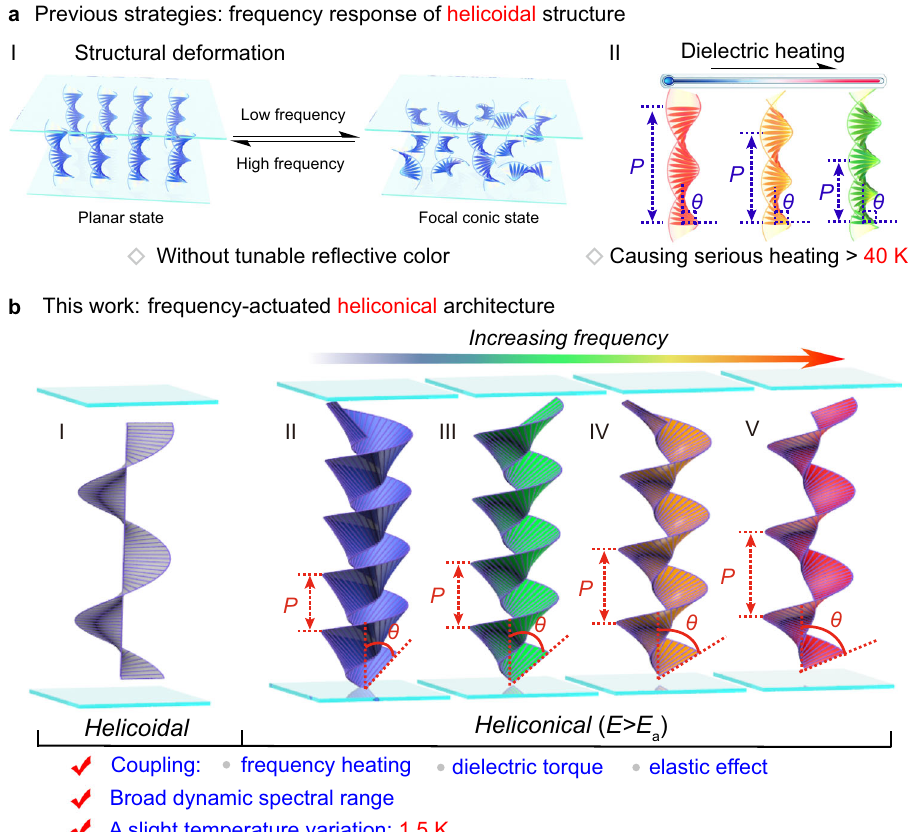
Fig. 1 Responsiveness of chiral liquid crystals to external electric fi eld frequency stimulation. a A diagrammatic sketch of the previous frequency response of (I) the structural deformation between the transparent planar state and scattering focal conic state of the helicoidal structure and (II) tuning the re fl ective color of the helicoidal structure through dielectric heating with an obvious thermal effect (over 40 K). The angle between the long axis of the LC molecule and the helical axis is always a right angle. b Schematic illustration of frequency-actuated heliconical soft architecture through delicate coupling among the frequency-dependent thermal effect, fi eld-induced dielectric torque and elastic equilibrium at a relatively low electric fi eld strength. (I) The helicoidal superstructure where LC molecules were perpendicular to the helical axis in the absence of an applied electric fi eld. (II) The heliconical superstructure with an electric fi eld signal across the LC cell of the initial frequency and strength E > E a , in which the LC molecules twisted around the helical axis with an oblique angle of θ . (II – V) The heliconical pitch length P and oblique angle θ increased with increasing frequency, resulting in wide spectral range tunability of the re fl ection spectrum. Herein, E a was the threshold of the transition from the helicoidal helix to the heliconical